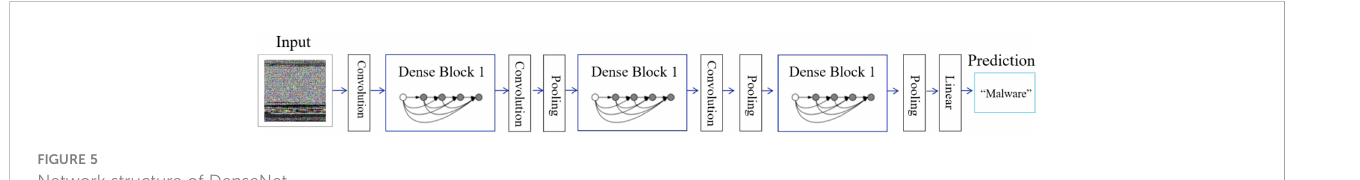
FIGURE 5 Network structure of DenseNet.